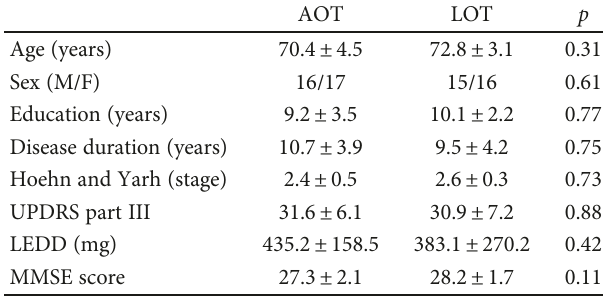
Table 1: Demographic and clinical characteristics of